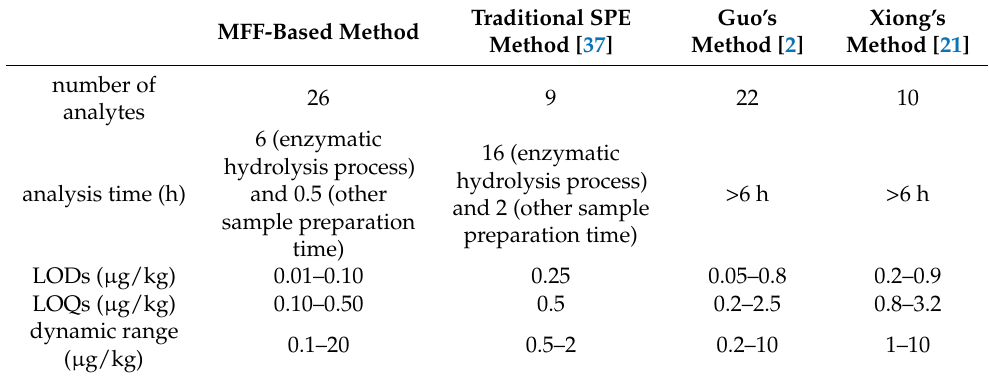
Table 4. Performance of MFF-based method for beta-agonists determination over existing methods.